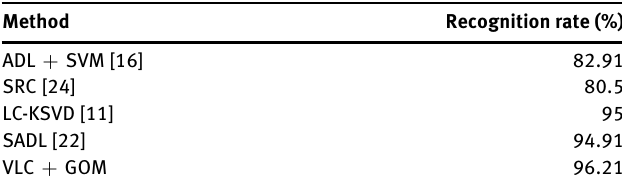
Figure 15: Results on the Whole FERET Database. Table 4: Results on Extended YaleB Database